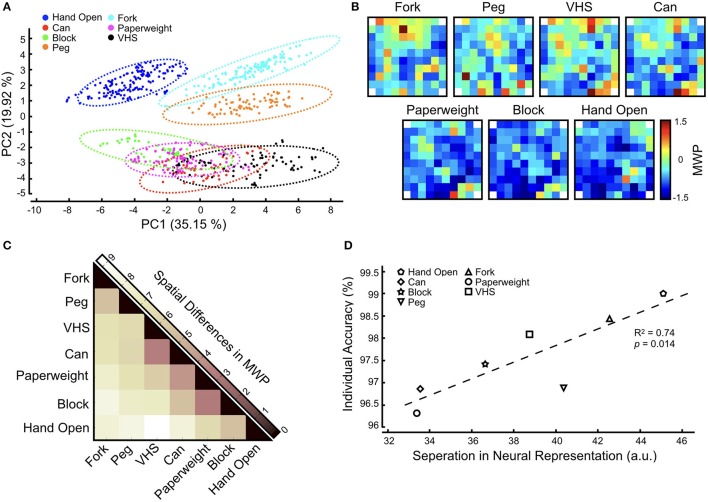
Neural representation of functional hand movements in the motor cortex. The participant was asked to attempt the cued hand movement. No FES was provided during this task so that neural data can be captured without any stimulation artifact. (A) Principal component analysis (PCA) of MWP activity shows clustering of neural activity for each hand movement during decoder activation for each functional movement. Dotted lines indicate a Gaussian mixture distribution model fit. (B) Heat maps of averaged MWP activity during neural decoder activation overlaid on the physical layout of the electrode array for each attempted hand movement. Corner reference (non-active) electrodes in the electrode array are labeled with white squares. (C) Heat map showing the pairwise Euclidean distances between vectorized MWP spatial patterns and highlights the separability in neural representation between different hand movements. Darker colors indicate that the neural representations are similar while lighter colors indicate that the representations are dissimilar. (D) Correlation between individual decoder accuracy and separation in neural representation (aggregate Euclidean distance for each movement) shows that higher neural discriminability leads to higher decoder accuracy. The trend line indicates a linear fit.